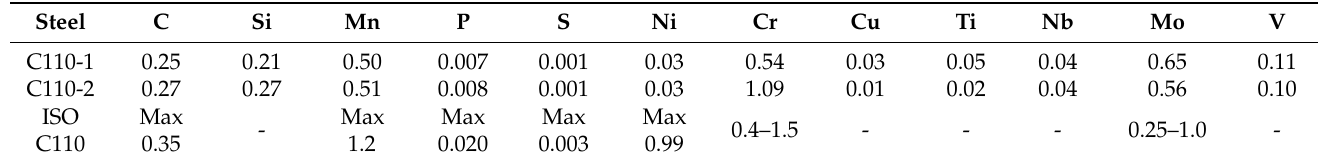
Table 1. Chemical compositions of C110-1 and C110-2 steels